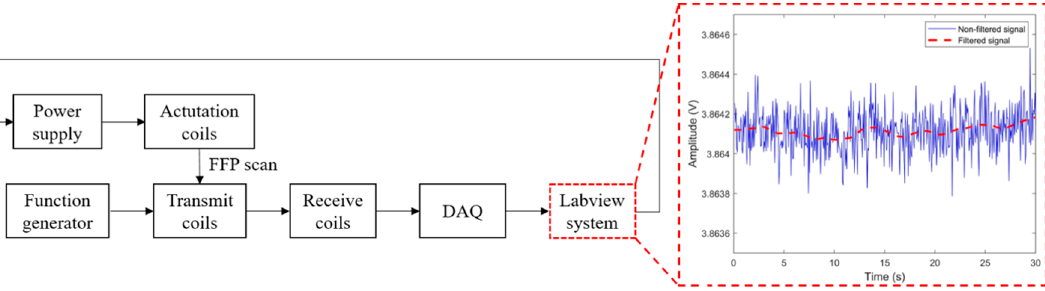
Figure 5. Flow chart depicting the sequence of operations in the proposed system. The signal graph on